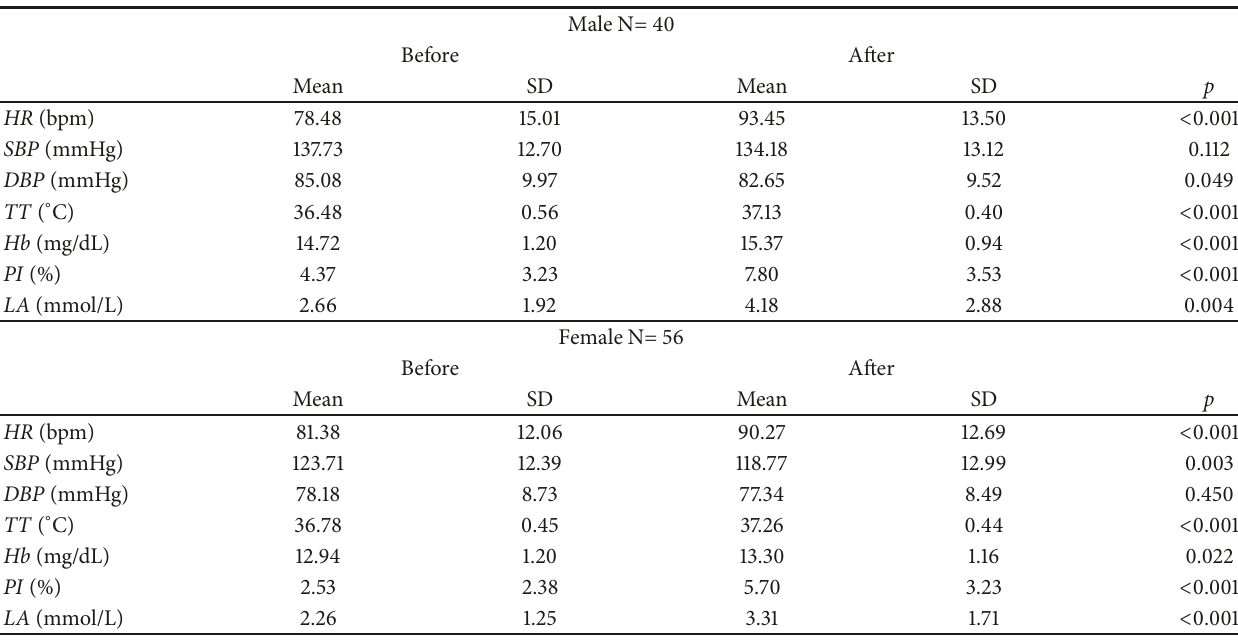
Table 4: Distribution of vital signs before/after by gender . Male N= 40 Before After SD